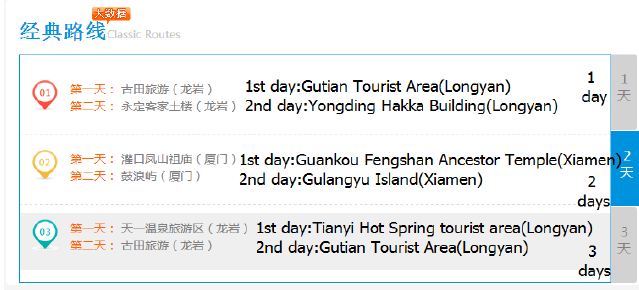
Figure 2. Route recommended routes in